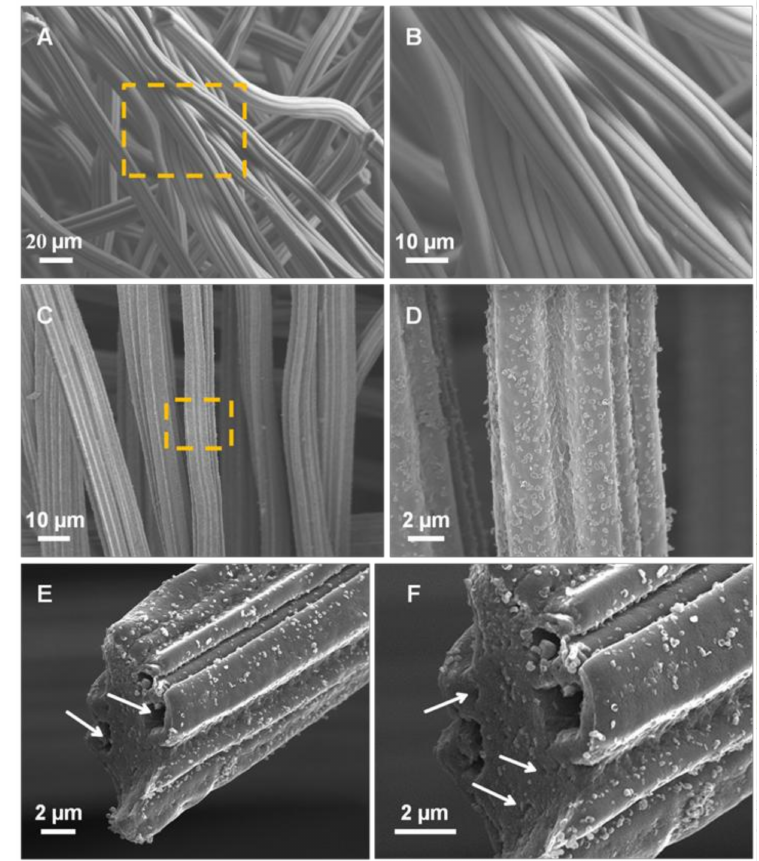
Figure 1. Scanning electron microscopy (SEM) micrographs of the ( A , B ) pristine commercial graphite felts (GFs), and ( C , D ) the same after treatment under gaseous HNO 3 at 250 ◦ C for 24 h, noted oxidized graphite felts (OGFs)-24 showing the formation of nanoscopic nodules on its surface. SEM micrographs with medium and high resolution ( E , F ) reveal the formation of cracks on the cross section of the OGFs-24 (indicated by arrows) as well as a rougher surface after acid